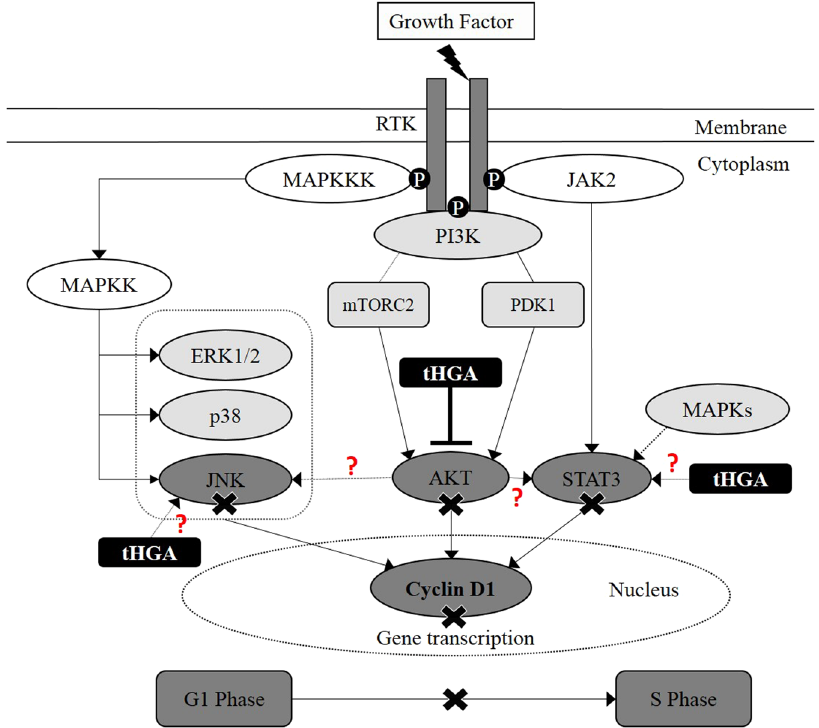
Figure 7. tHGA attenuates hBSMCs proliferation primarily via AKT inhibition. AKT was suggested to act as upstream activator for JNK and STAT3, thus making it more of the primary target of tHGA. However, further molecules (AKT, JNK and STAT3) reduced cyclin D1 protein expression, thus causing cell cycle arrest at G 1